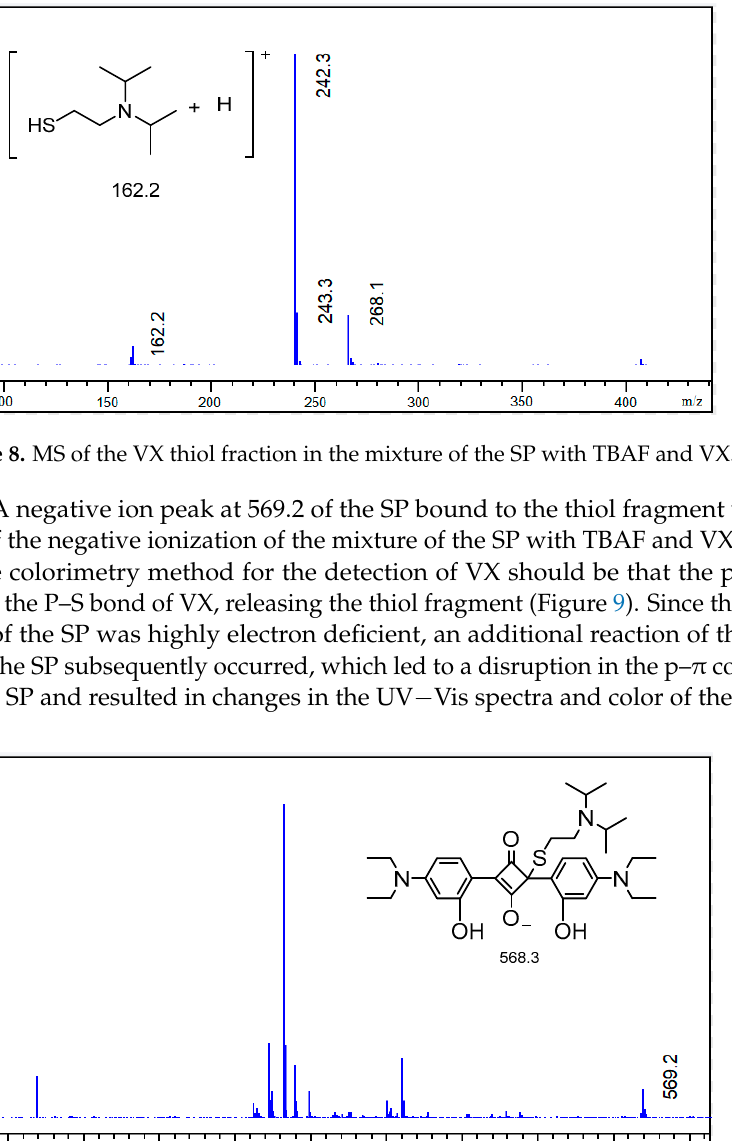
Figure 9. MS of the adducts of the SP and VX thiol in the mixture of the SP with TBAF and VX.